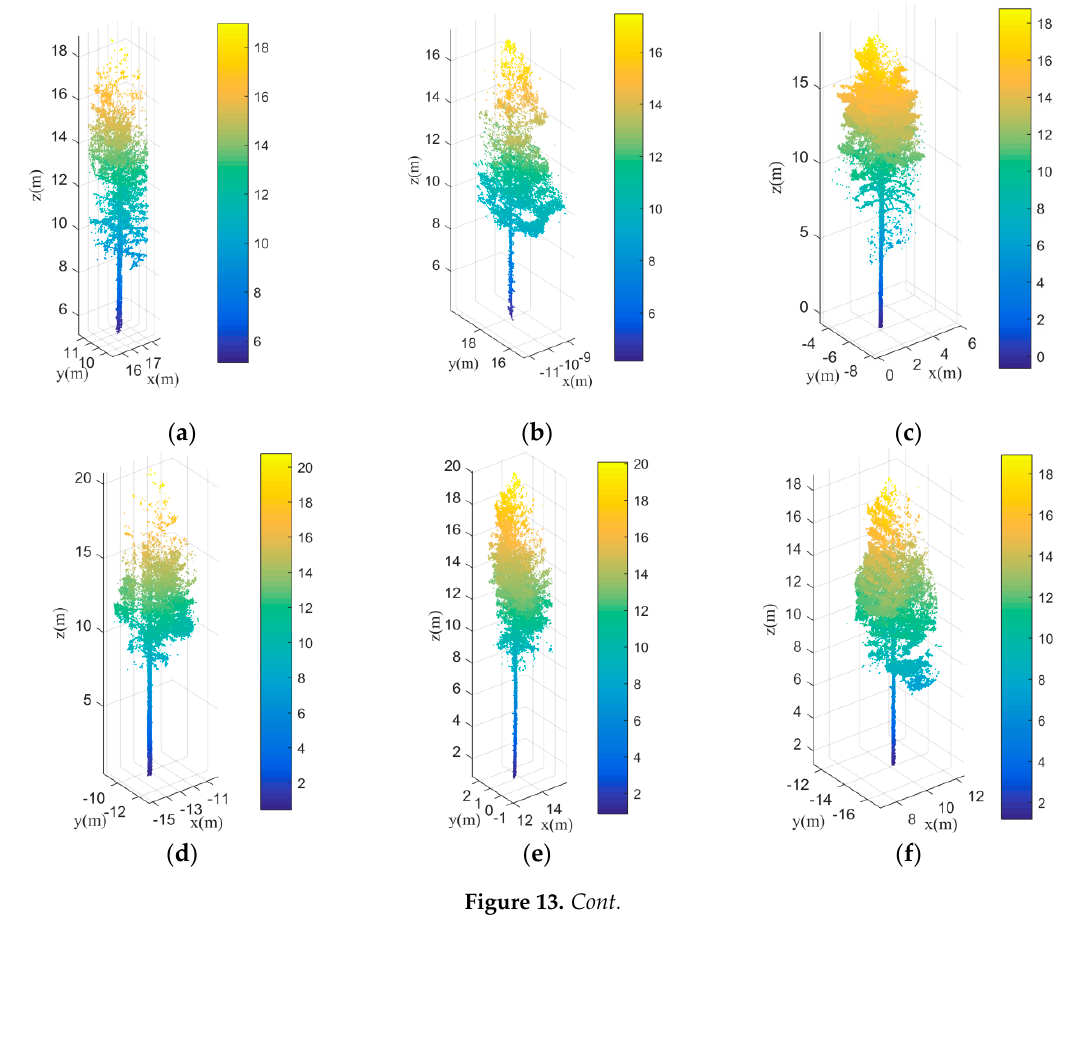
Figure 12. Extracted trunk stems for the six plots scanned in both single-scan and multi-scan modes. ( a , b ) are the extracted stems for Plot 1; ( c , d ) are the extracted stems for Plot 2; ( e , f ) are the extracted stems for Plot 3; ( g , h ) are the extracted stems for Plot 4; ( i , j ) are the extracted stems for Plot 5; ( k , l ) are the extracted stems for Plot 6; the first column represents the single-scan mode, while the second column represents the multi-scan mode.